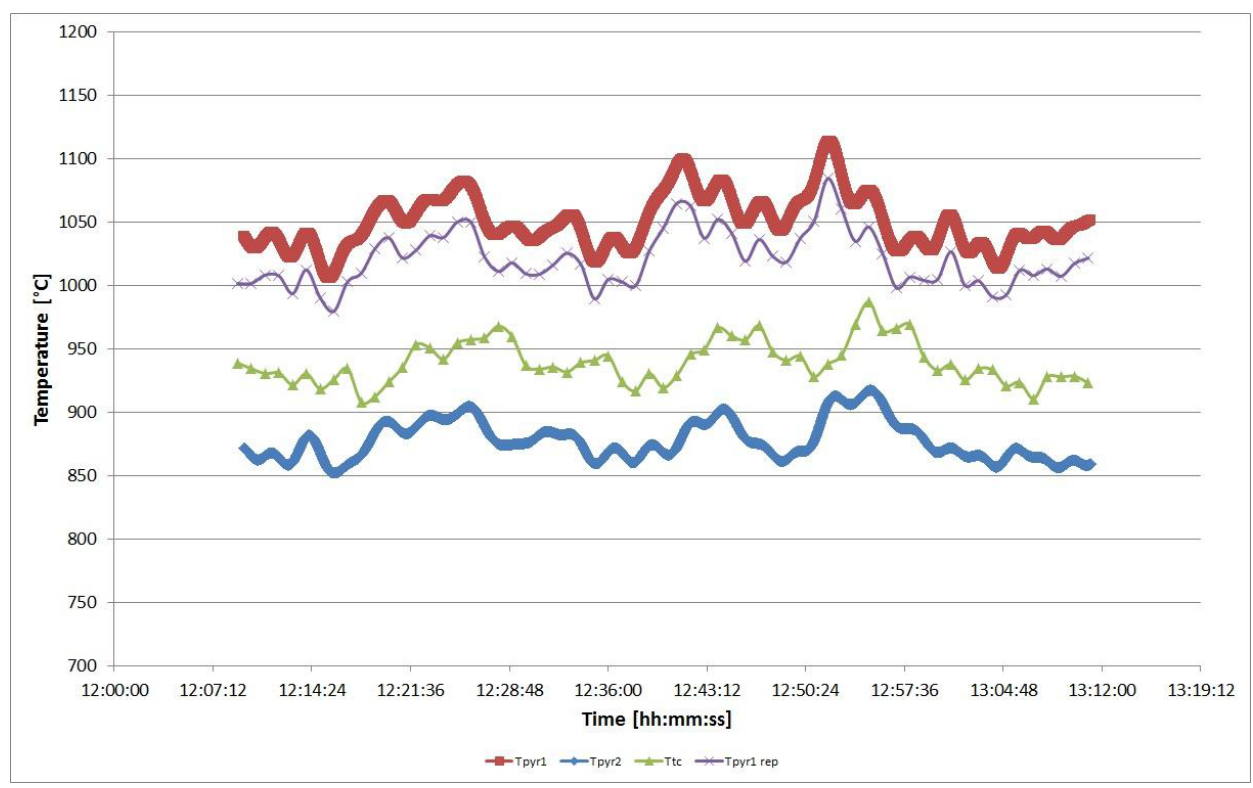
Figure 9. Temperature measured during the calibration by pyrometer 1, pyrometer 2 and by the bare